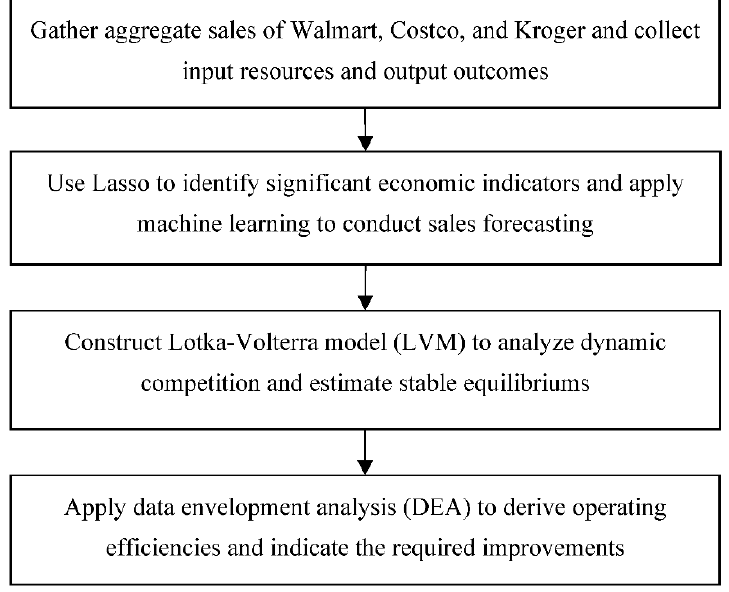
Figure 1. Proposed research techniques.